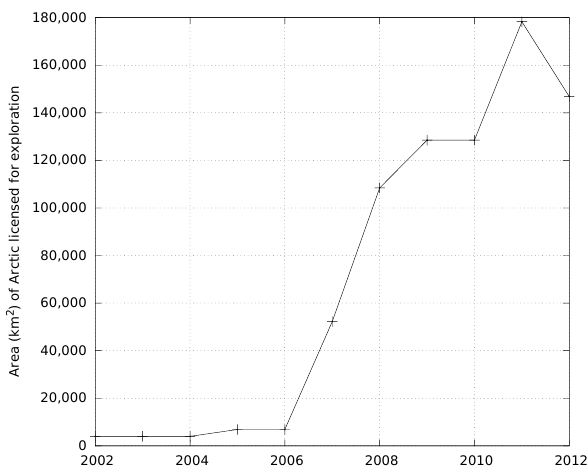
Figure 2. Area of Arctic licensed for oil exploration in Greenland, derived from NUNAOIL annual report 2012 (Olsen,